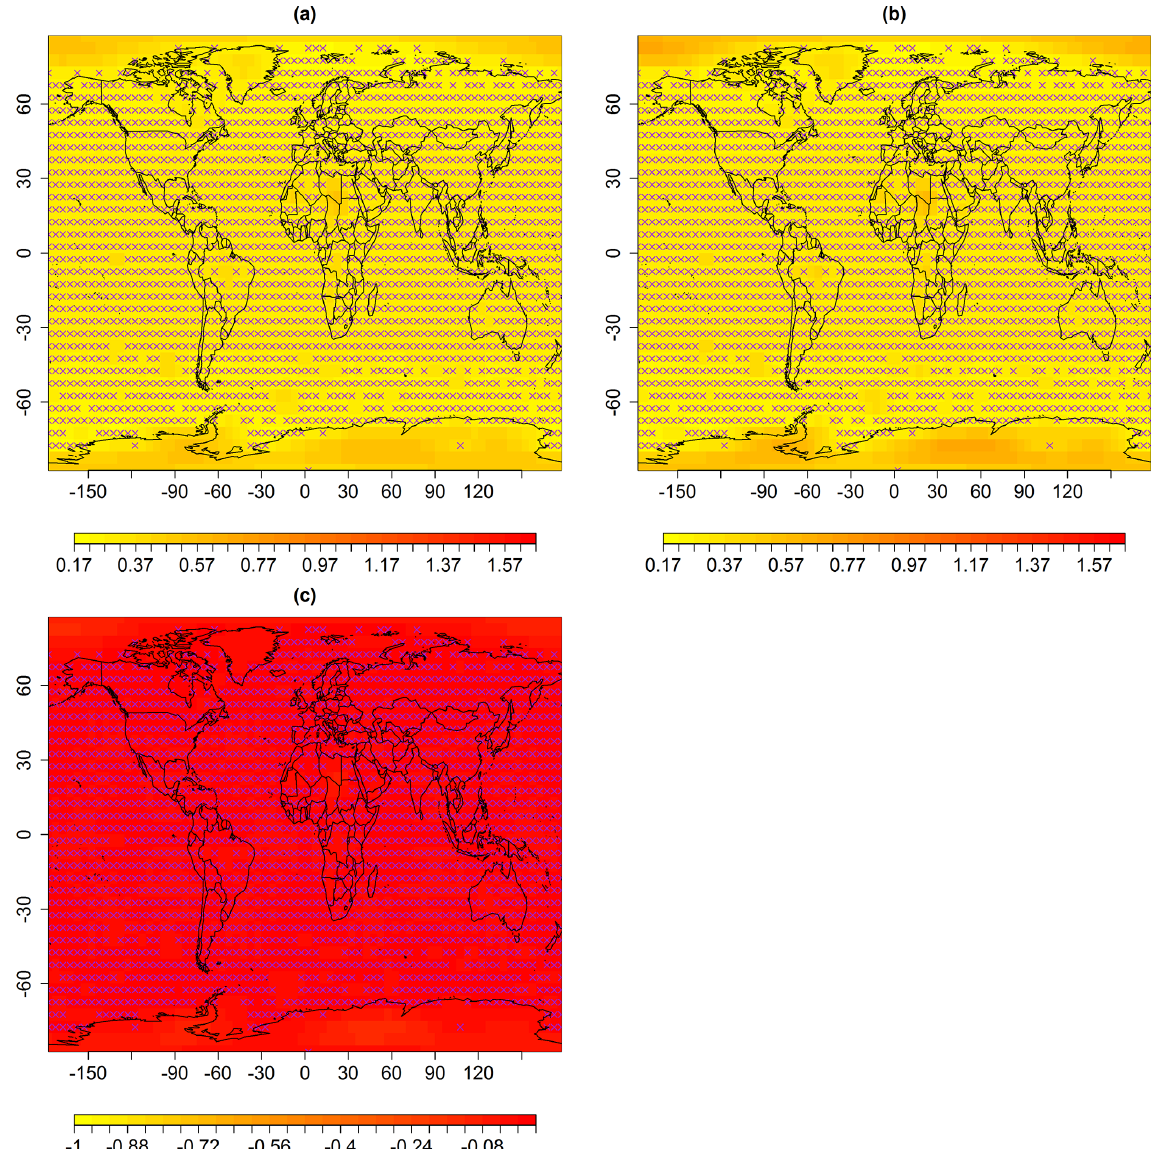
Figure B4. Standard error (uncertainties) in degrees Celsius associated with spatial predictions for the median in February 1988, using multi- resolution lattice kriging, based on (a) ABC, using a variogram (Sect. 2.1), and (b) the profile maximum likelihood approach (Nychka et al., 2015) used to create data in Ilyas et al. (2017). (c) The difference in panels (a) and (b) , i.e., (a) – (b) . The × signs show observed spatial sites